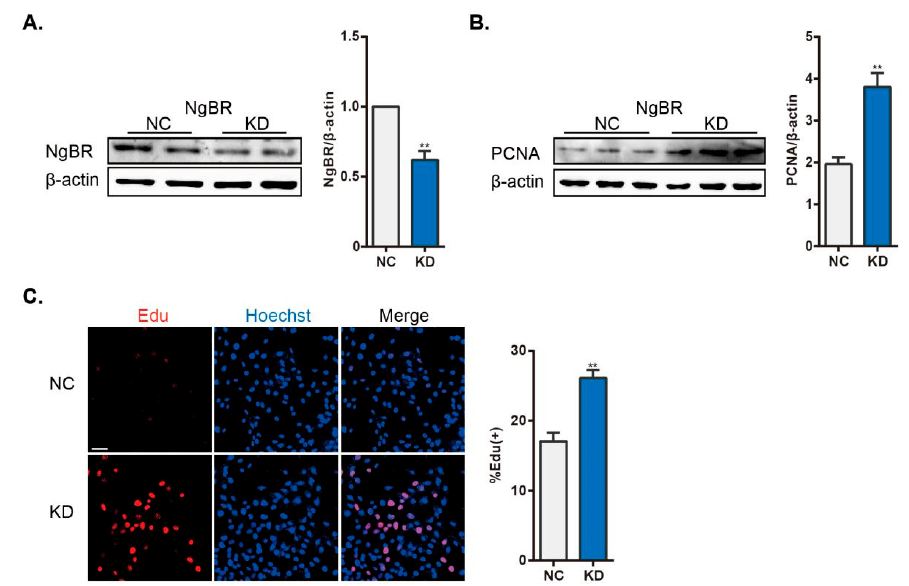
Figure 2. Increased proliferation in NgBR KD cells under normoxia. ( A ) The e ffi ciency of shNgBR transfection was verified at 48 h post transfection, the statistical comparisons histogram from three independent experiments. ( B ) Cell proliferation was assessed by evaluating PCNA expression, n =